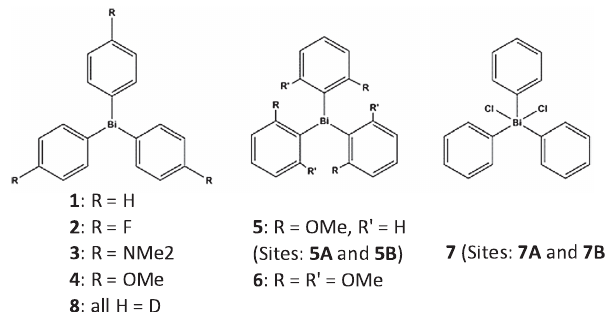
FIG. 3. Overview of Bi-aryl compounds and their structures: triphenylbismuth (1), tris(4-fluorophenyl) bismuth (2), tris(4- dimethylaminophenyl) tris(4-methoxyphenyl) bismuth (4), tris(2-methoxyphenyl) bismuth (5) (5A and 5B), tris(2-6-dimethoxyphenyl) bismuth (6), triphenylbismuth dichlo- ride (7) (7A and 7B), and fully deuterated triphenylbismuth